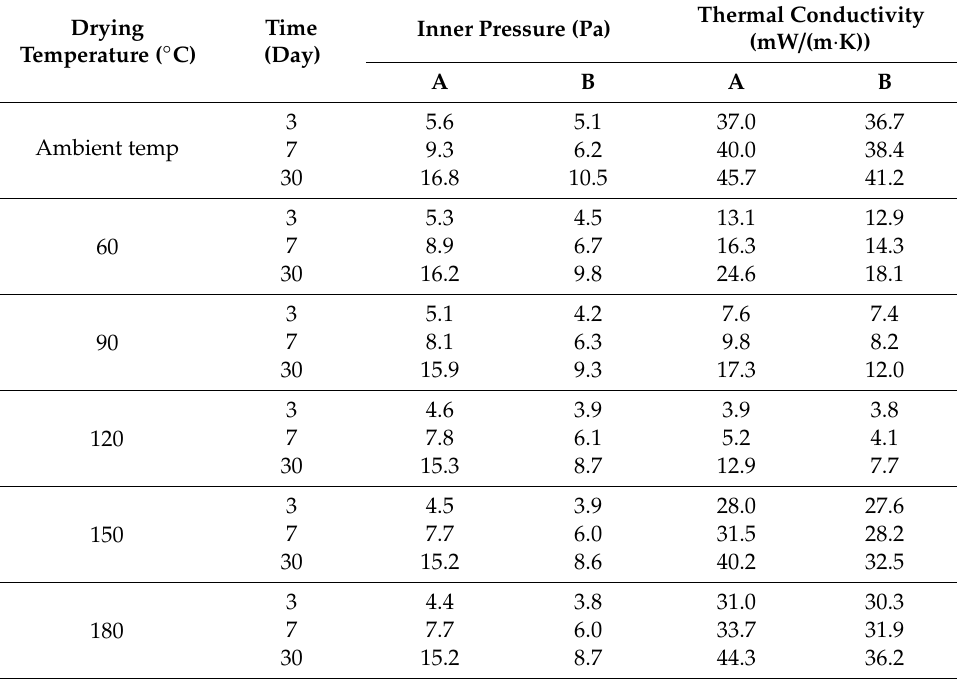
Table 3. Vacuum level within the VIP envelope enclosure changing with time.